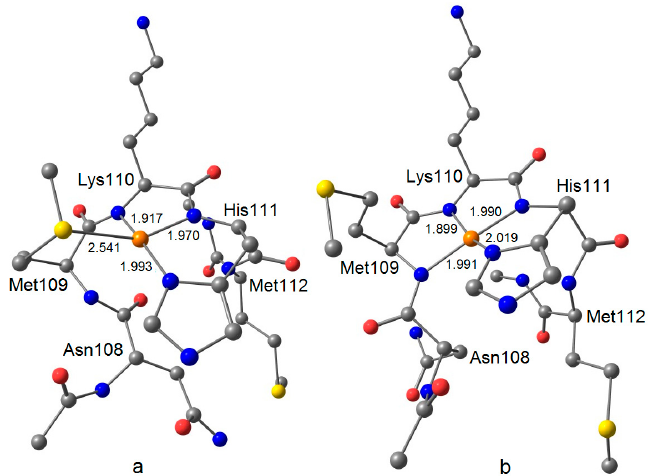
Figure 5. Optimized structure at the level of theory B3LYP-D3 of the adduct formed by Cu(II) with the pentapeptide Ac–AsnMetLysHisMet–NHCH 3 (region 108–112 of PrP): ( a ) [Cu(H –1 L)] + and ( b ) [Cu(H –2 L)]. The Cu–donor distances (in Å) are also indicated. Hydrogen atoms are omitted for clarity.